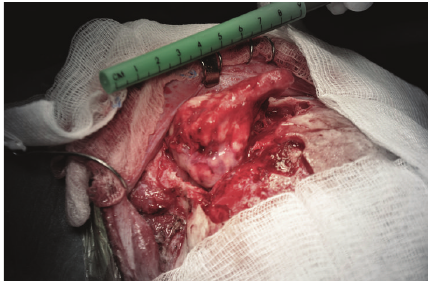
Figure 2: Intraoperative photo showing the large osteoma exposed through a fronto-orbital surgical